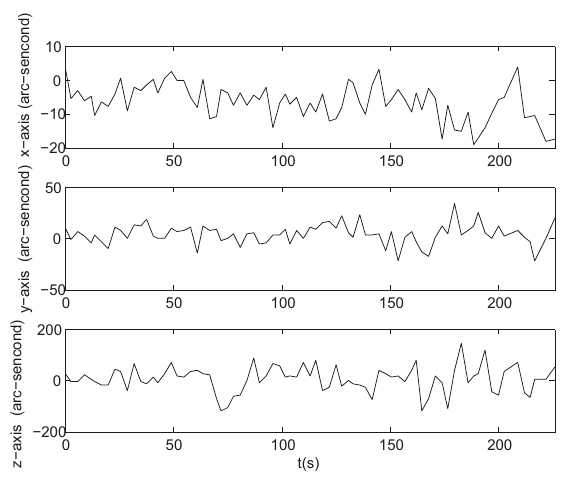
Figure 15. Attitude estimation errors of a night sky experiment.